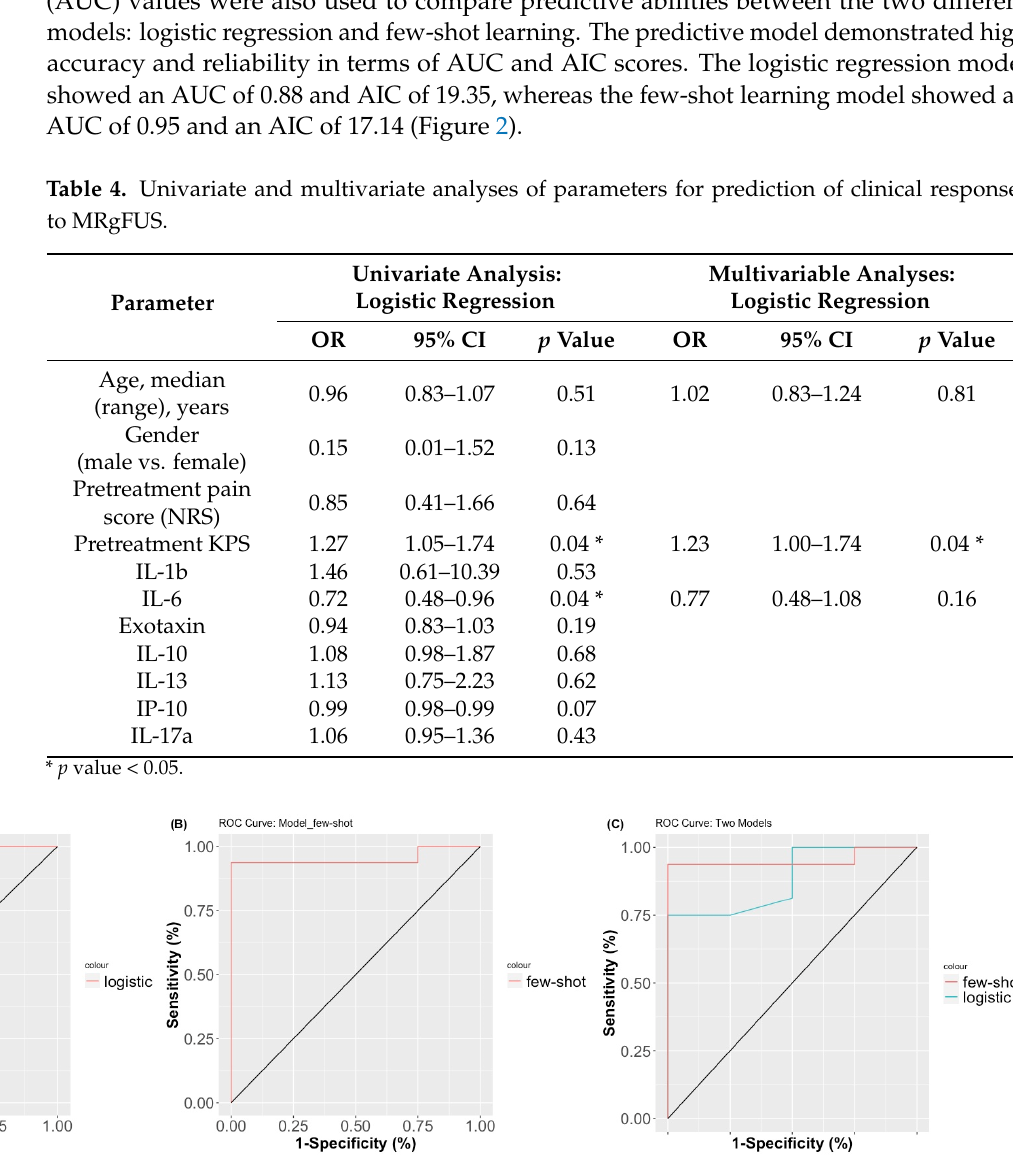
Figure 2. ROC curves of each prediction model. ( A ) Multivariable logistic regression model with stepwise parameter selection (AUC: 0.88); ( B ) few-shot learning classification (AUC: 0.95); ( C ) merged ROC curve. Table 4. Univariate and multivariate analyses of parameters for prediction of clinical responses to MRgFUS.